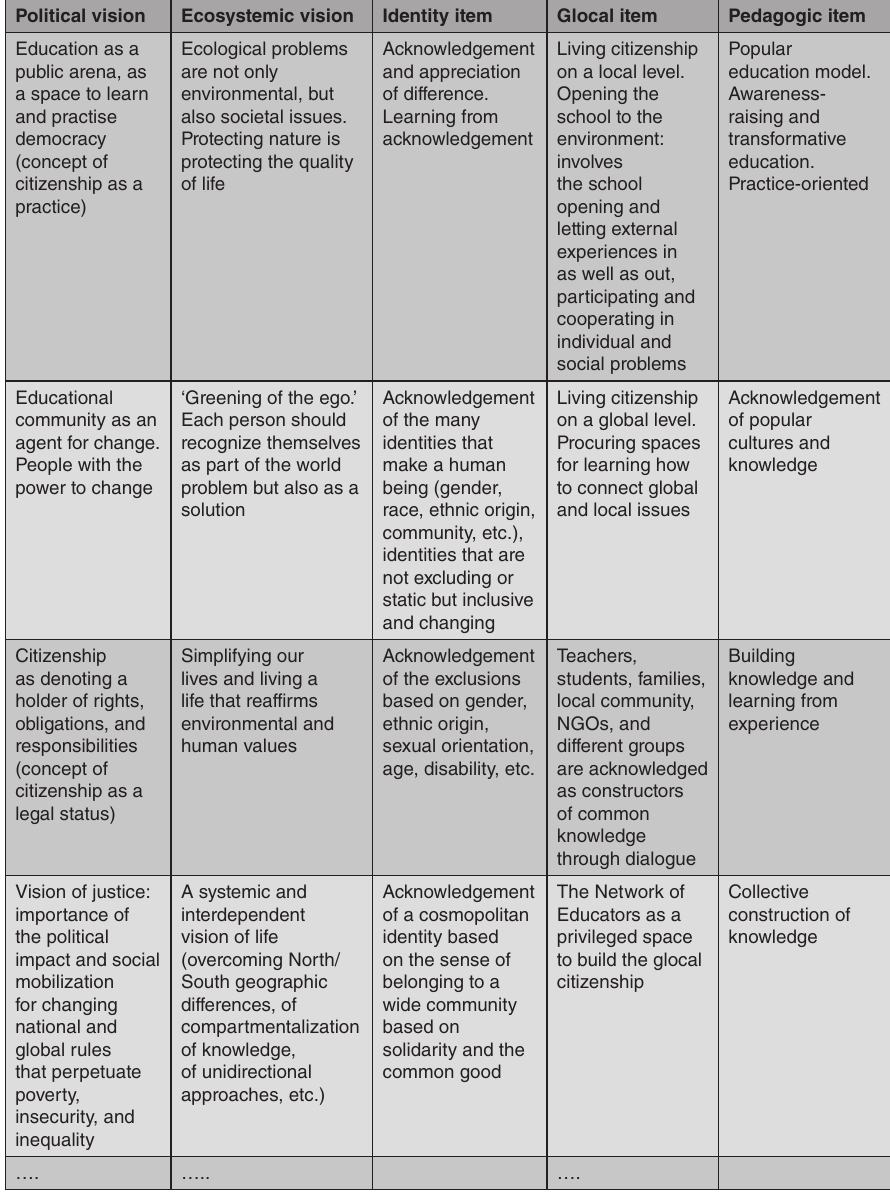
Figure 1: The Network of Educators’ key principles of the